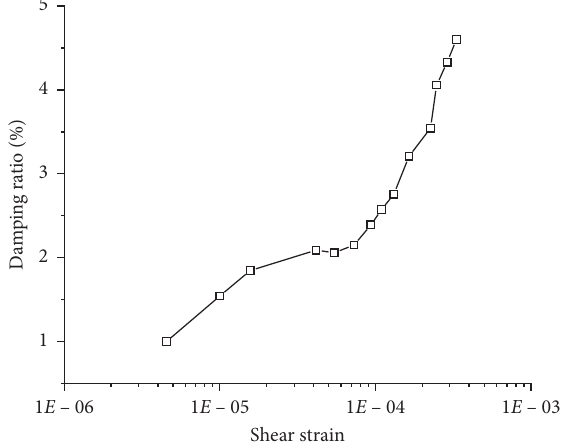
Figure 16: Variation of damping ratio with dynamic shear